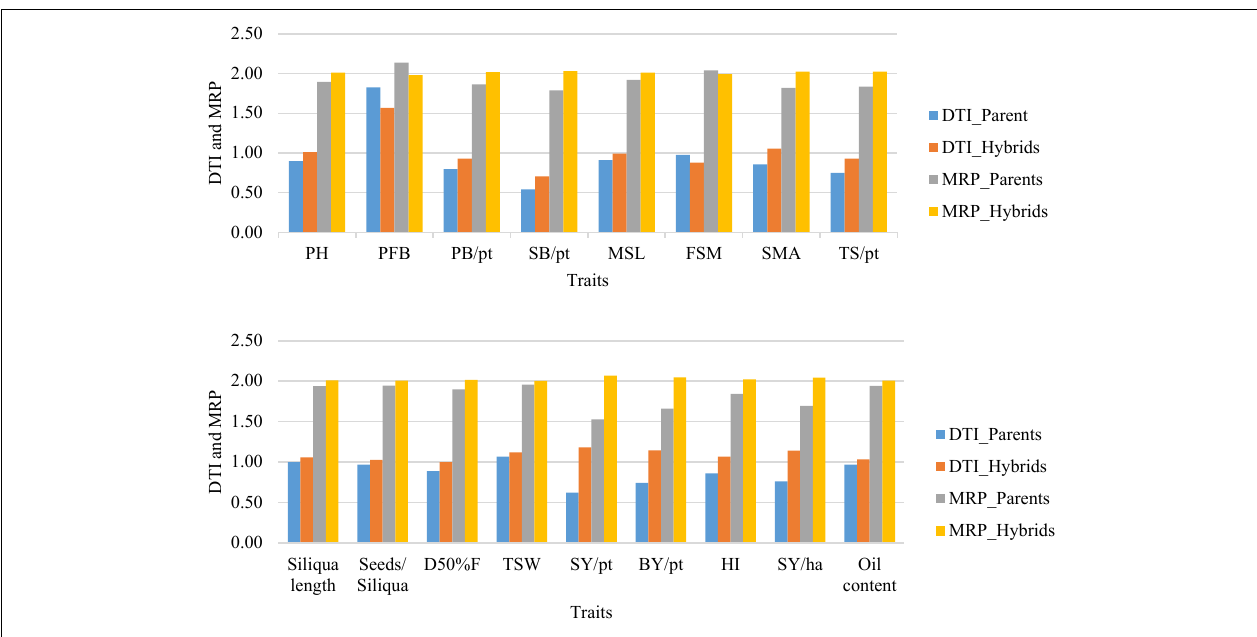
FIGURE 2 | The drought tolerant index (DTI) and mean relative performance (MRP) observed on seventeen traits in hybrids along with parents grown in rainfed and irrigated conditions. PH, plant height; PFB, point to first branch; PB/pt, primary branches/plant, SB/pt, secondary branches/plant; MSL, main shoot length; FSM, point to first siliqua on main shoot; SMS, number of siliquae on main shoot; TS/pt, total siliquae/plant; D50%F, day to 50% flowering; TSW, thousand seed weight; SY/pt, seed yield/plant; BY/pt, biological yield/plant; HI, harvest index; SY/ha, seed yield kg per